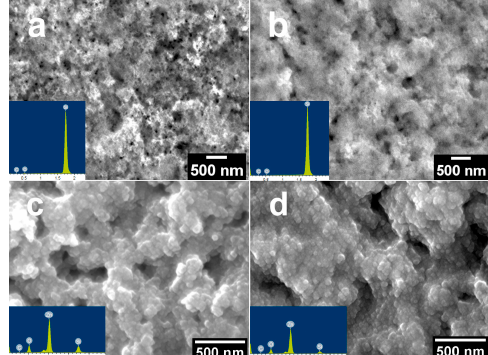
Figure 1. SEM images of porous silicon (PSi) surface before and after 100 cycles of zinc oxide ALD: ( a ) n-type PSi; ( b ) p-type PSi; ( c ), ( d ) n-and p-types PSi after zinc oxide (ZnO) deposition, respectively (insets: an EDX analysis).